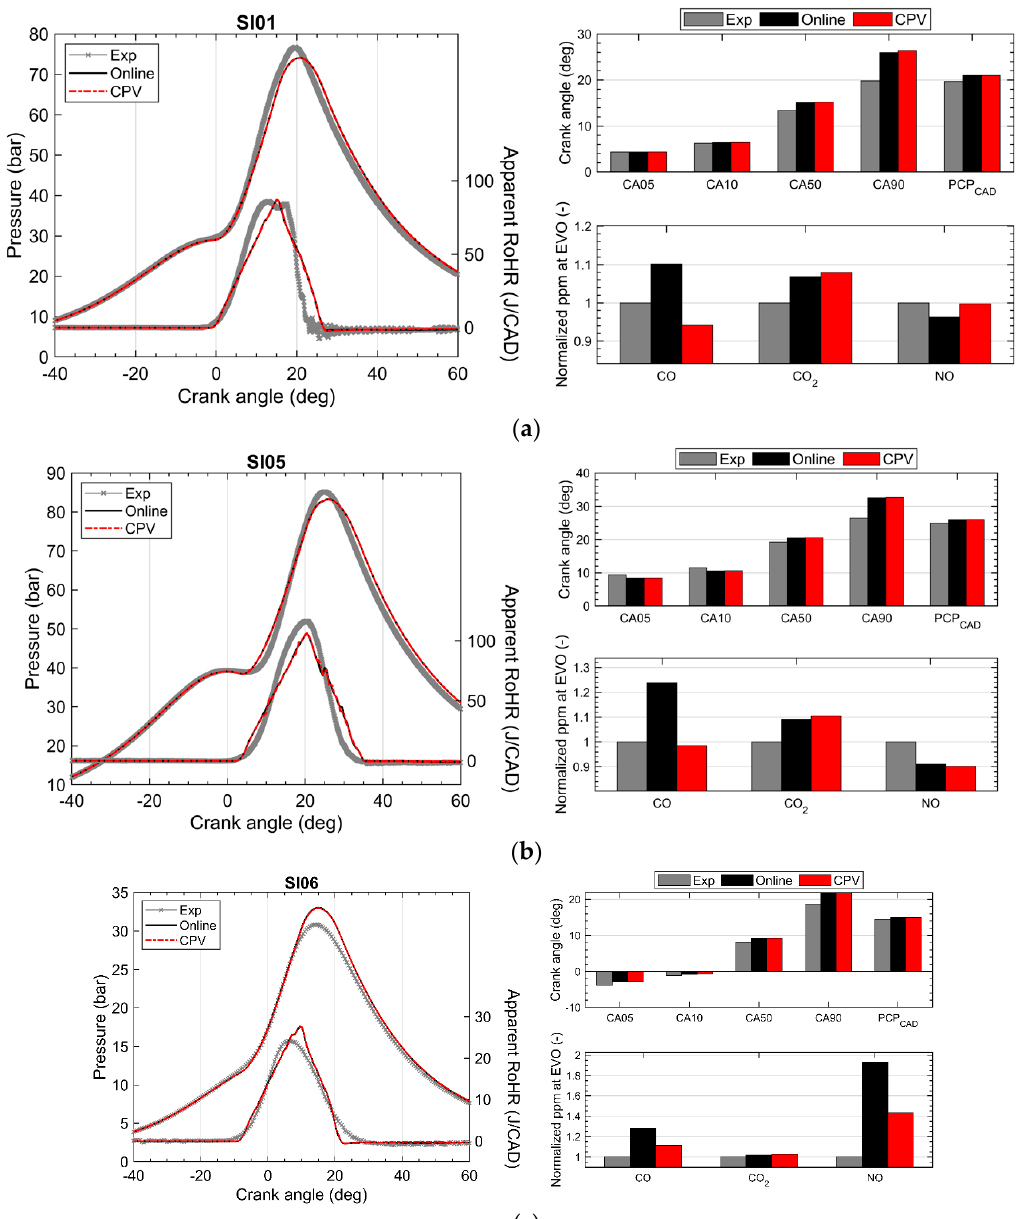
Figure 9. In-cylinder pressure history and apparent rate of heat release (left), combustion phasing parameters (top right) and normalized engine-out emissions (bottom right) comparisons between experimental data and SRM simulations for operating points SI01 ( a ), SI05 ( b ) and SI06 ( c ).